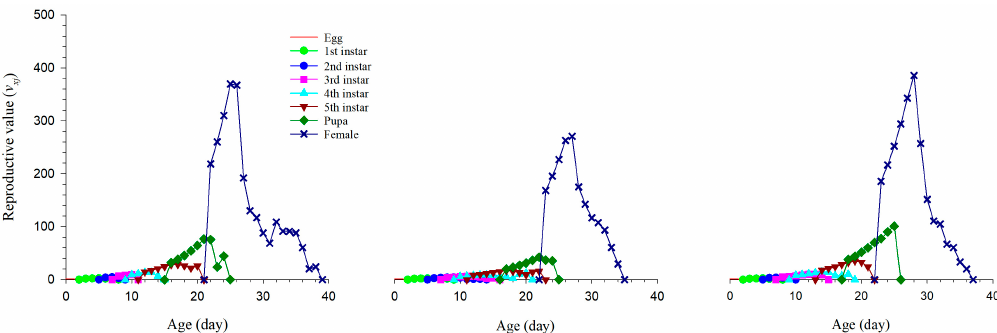
Figure 4. The reproductive value of S. exigua ( v xj ) under three nutritional conditions.